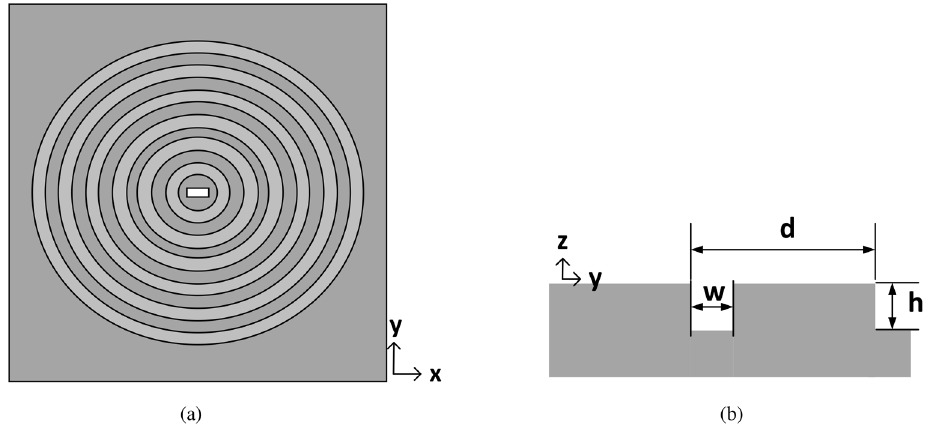
Figure 1. Standard Bull’s Eye antenna with N = 6 rings. ( a ) Front view. ( b ) Cross section of a unit cell with design details.